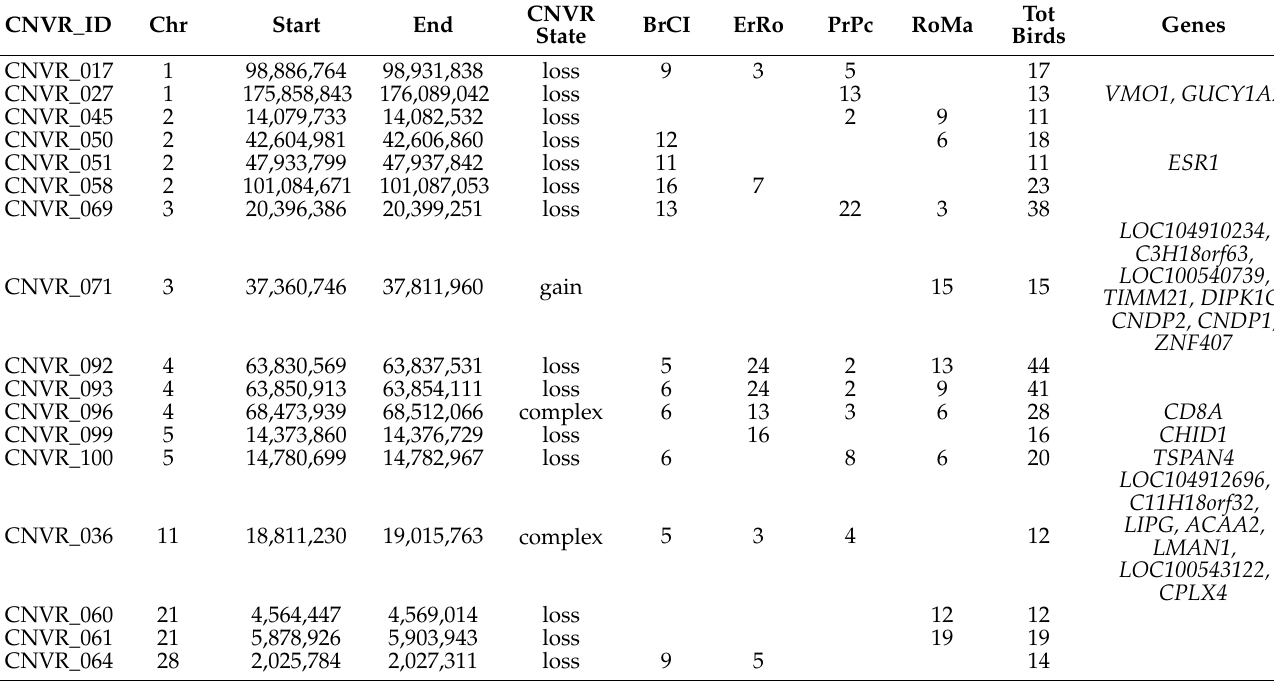
Table 4. List of CNVRs mapped in at least 10 animals. For each CNVR, the number of birds per breed is reported together with their total and the annotated